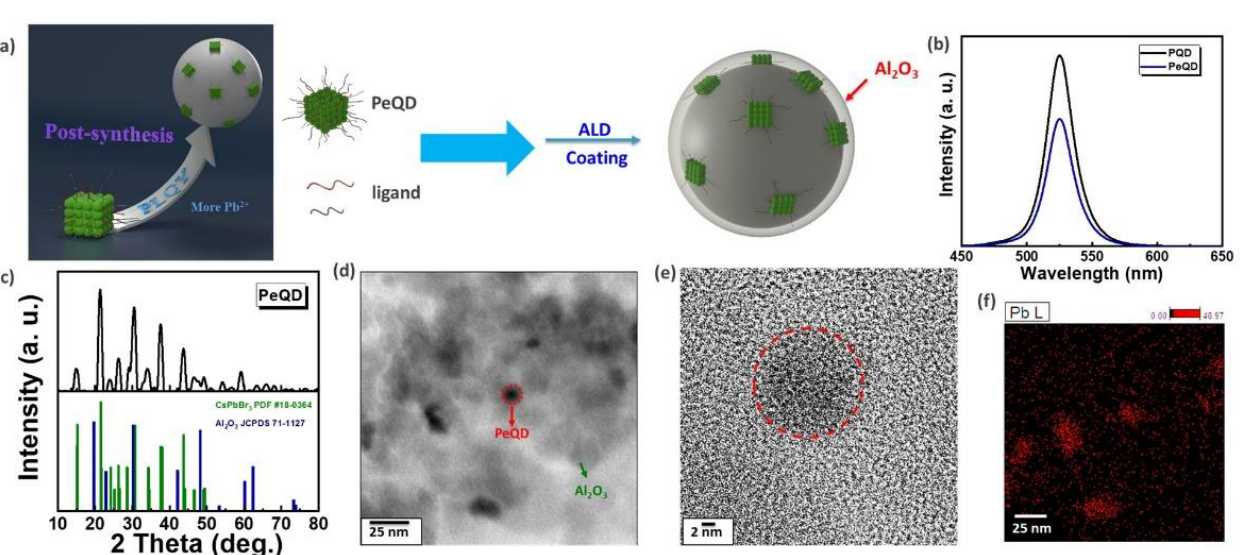
Figure 1. Surface topography analysis of PeQDs. ( a ) Schematic diagram of surface modification. ( b ) Spectra of PQDs and PeQDs. ( c ) XRD image. ( d ) TEM image. ( e ) High-magnification TEM image. ( f ) Mapping analysis image.